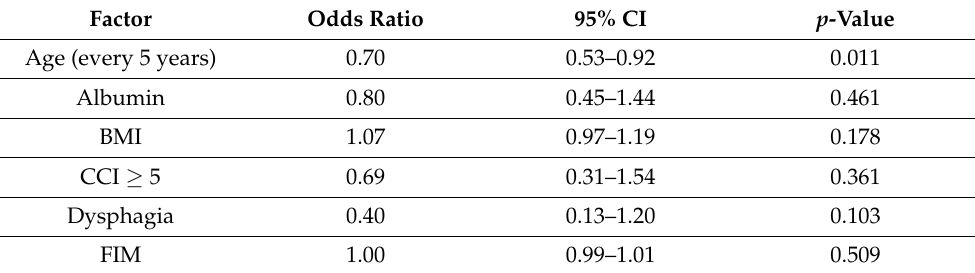
Table 3. Association between anemia recognition and influencing